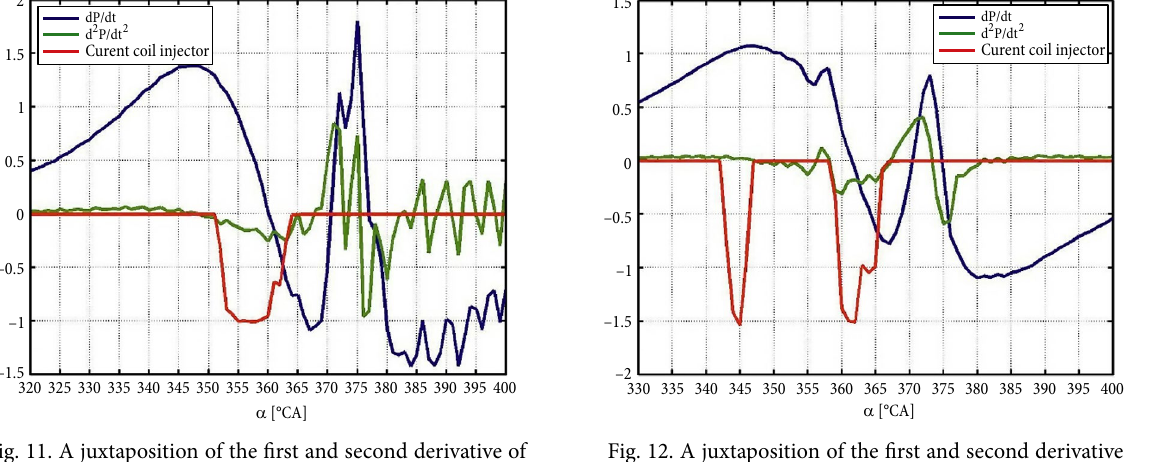
dP/dt d P/dt Curent coil injector